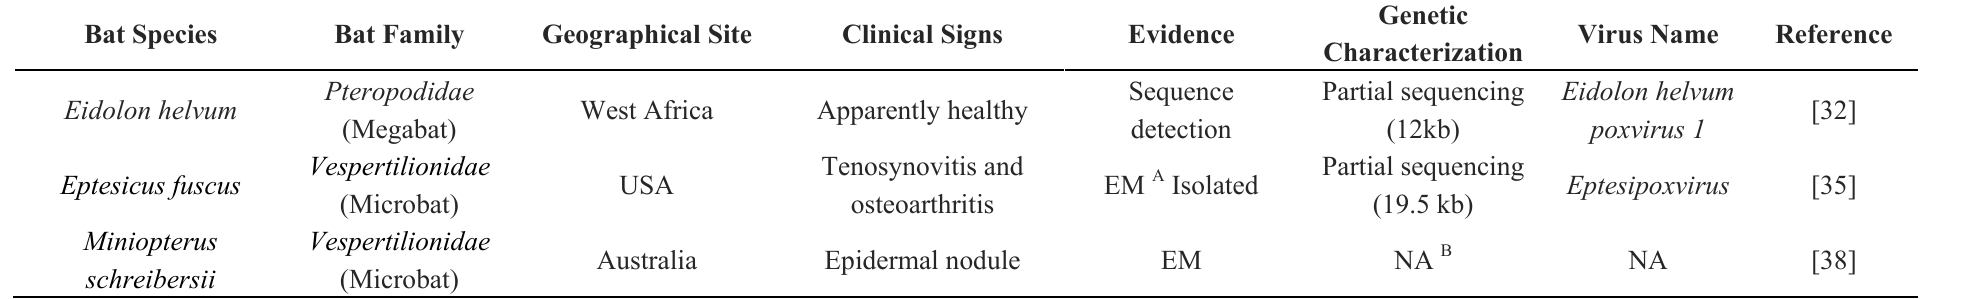
Table 1. Summary of poxvirus detections in bat